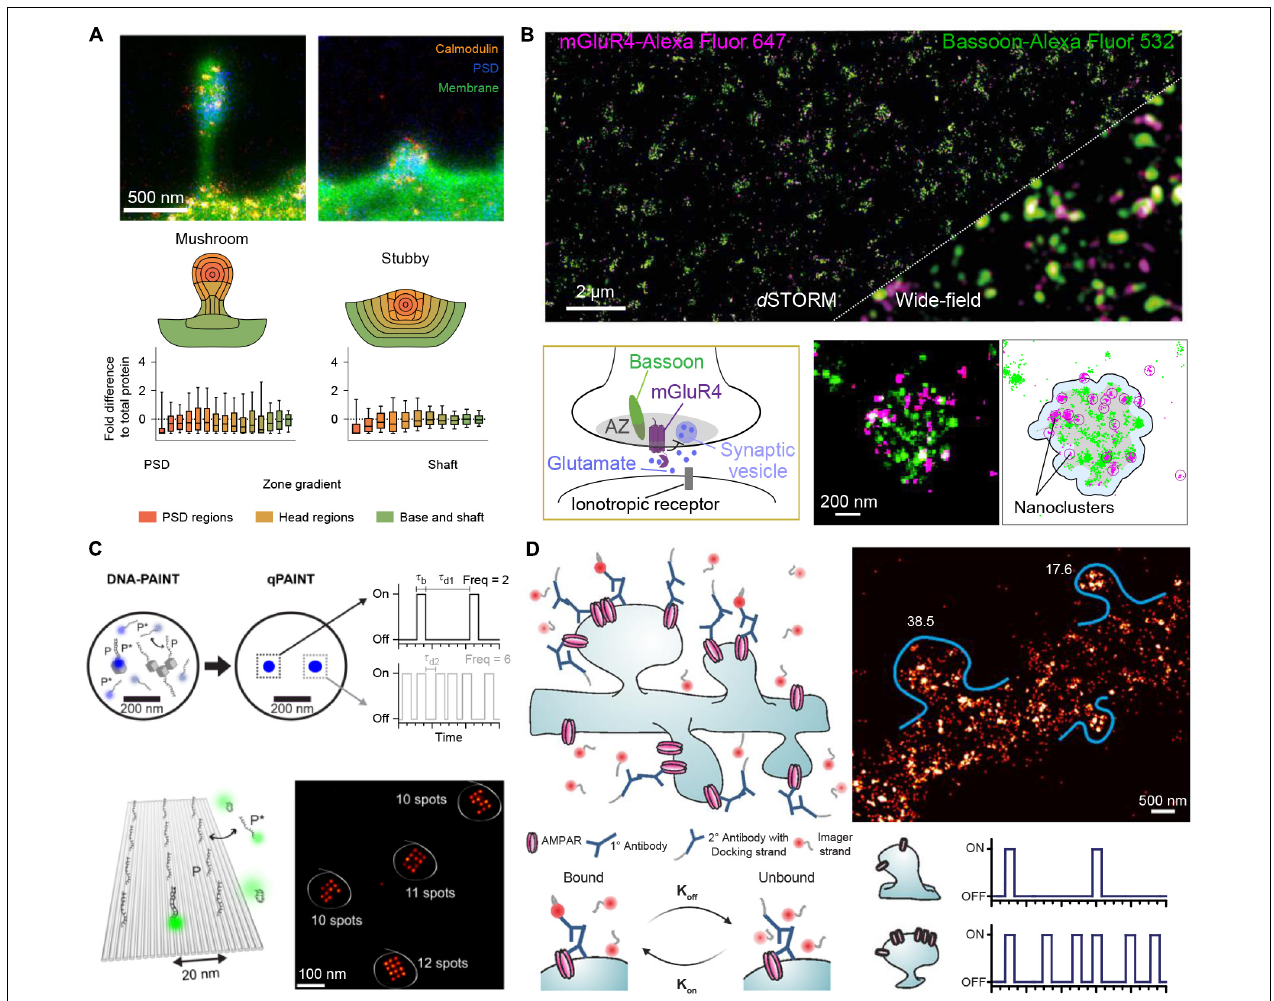
FIGURE 1 | Quantitative SR imaging of neuronal targets. (A) STED nanoscopy for quantification of Calmodulin protein copy numbers in dendritic spines. The top shows examples for mushroom-like and stubby dendritic spines visualized by the membrane stain DiO in green, the Postsynaptic density by Homer1 in blue and the protein of interest, Calmodulin, in orange. The bottom shows the protein enrichment separated into regions of the dendritic spines, in total n = 150 mushroom-like and n = 140 stubby spines were analyzed showing an overall similar distribution for both spine types. Adapted with permission (Helm et al., 2021). (B) d STORM microscopy for determining mGluR4 clusters at synaptic active zones. Top shows a comparison of a two-color d STORM image of mGluR4 (Purple) and the presynaptic active zone marker Bassoon (green) to the respective diffraction-limited image. Bottom shows a schematic of the mGluR4 located at the presynaptic active zone (AZ) and DBSCAN cluster analysis of Bassoon and mGluR4 for determining the area (gray) of the AZ and mGluR4 nanoclusters. Adapted with permission (Siddig et al., 2020). (C) qPAINT implementation. In DNA-PAINT, fluorescently labeled “imager” strands (P*) transiently bind from solution to complementary “docking” strands (P) attached to a target. Intensity vs. time traces show characteristic fluorescence on- and off-times ( τ b and τ d , respectively). qPAINT uses the predictable blinking kinetics to deduct absolute molecule numbers. Top shows two exemplary regions imaged by DNA-PAINT and evaluated by qPAINT. From a single emitter (single gray cube) the imager-specific kinetics, the bright time and dark time can be extracted. Afterward this extracted dark time can be used to calculate the number of single emitters in a more crowded region where molecular resolution cannot be achieved (three cubes). Bottom shows the respective results in an exemplary 12 binding site DNA origami surface, where qPAINT correctly predicts the amount of available binding sites per structure. Adapted with permission (Jungmann et al., 2016). (D) Quantification of AMPA receptor complexes by qPAINT on GluA2 receptors. Top left shows an illustration of DNA-PAINT labeling and imaging of dendritic spines via primary and secondary antibodies. Bottom: By analyzing the kinetic traces of subregions of the dendrites, molecular counting can be achieved by comparing the average dark time for the regions to single binding sites for calibration. Top right shows the qPAINT results for two dendritic spines. Adapted with permission (Boger et al., 2019).